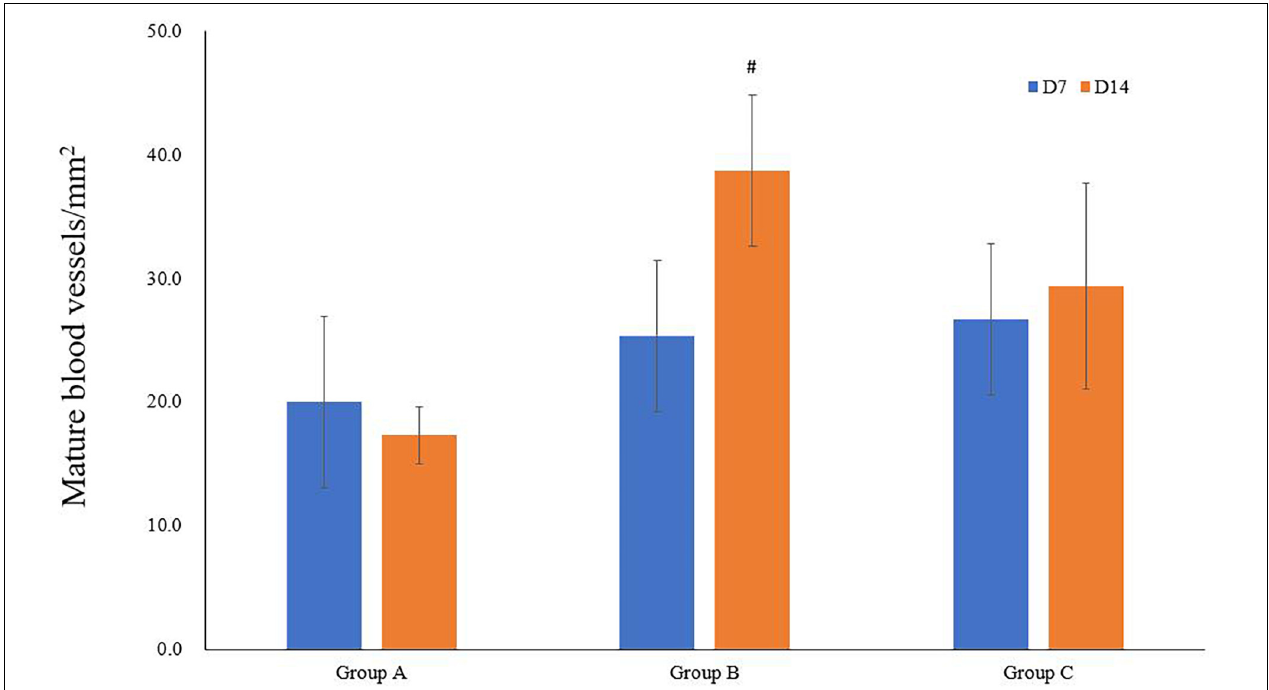
FIGURE 8 | Quantitative analysis of mature blood vessel densities. # P < 0.05 vs. group